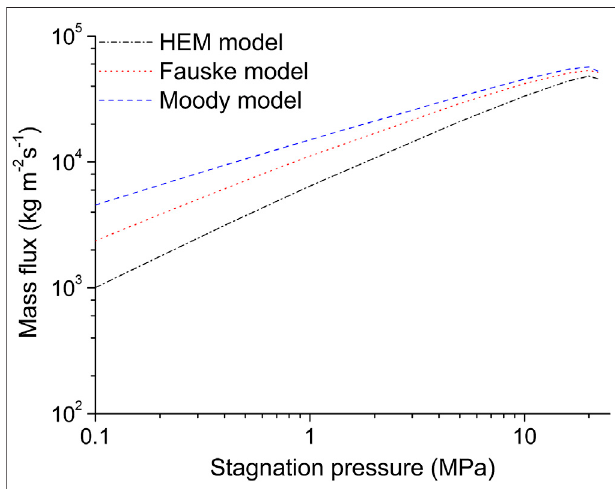
FIGURE 1 | Variation of mass fl ux with stagnation pressure for saturated water.